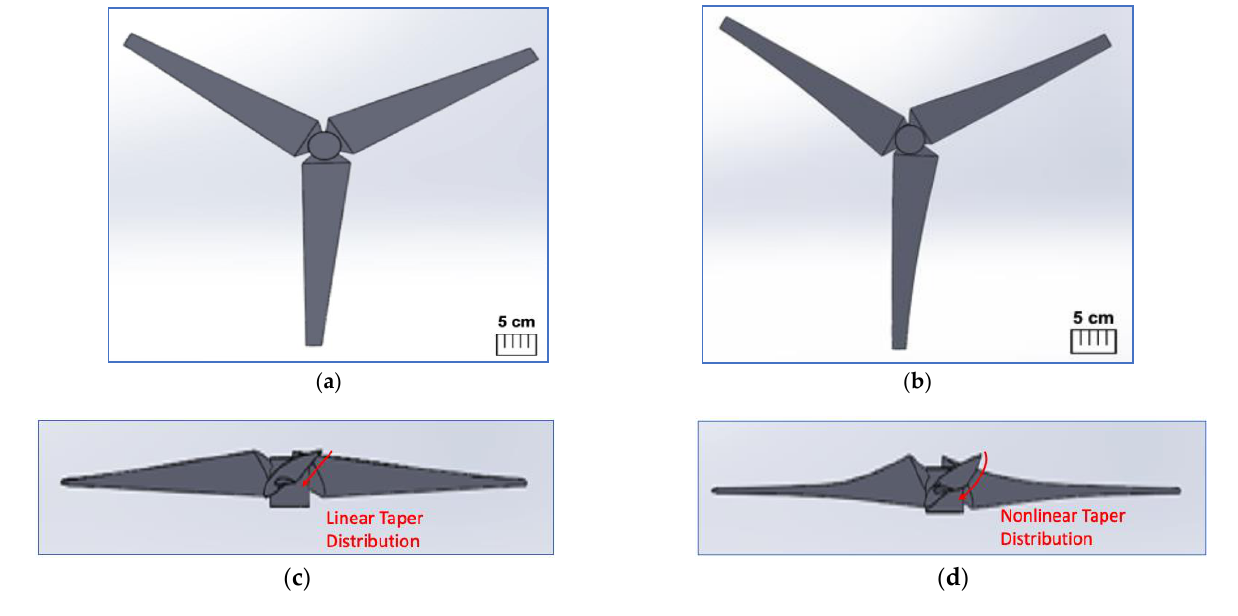
NACA4412 airfoil, with x-z view ( top ) and y-x view ( bottom ).